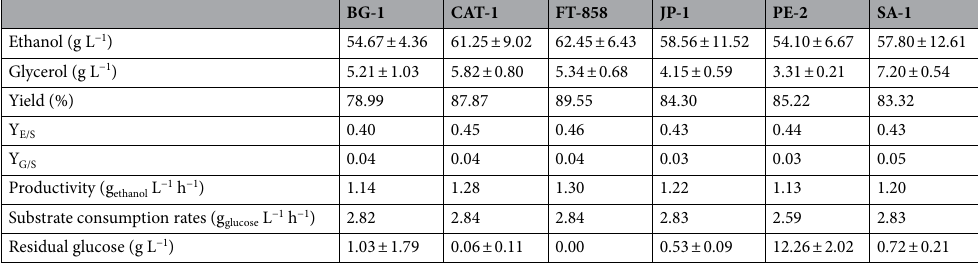
Table 2. BRS AG rice fermentation with different strains of Saccharomyces cerevisiae parameters (N.B. standard deviation was determined from the essays carried out in